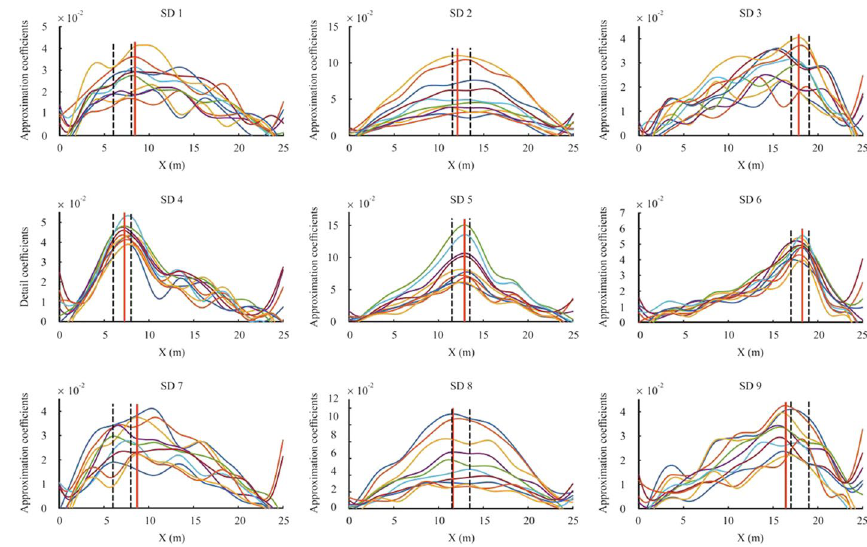
Fig. 17 The ninth order approximation coefficient curve of the signal along the X axis for 9 single damage scenarios in the presence of noise